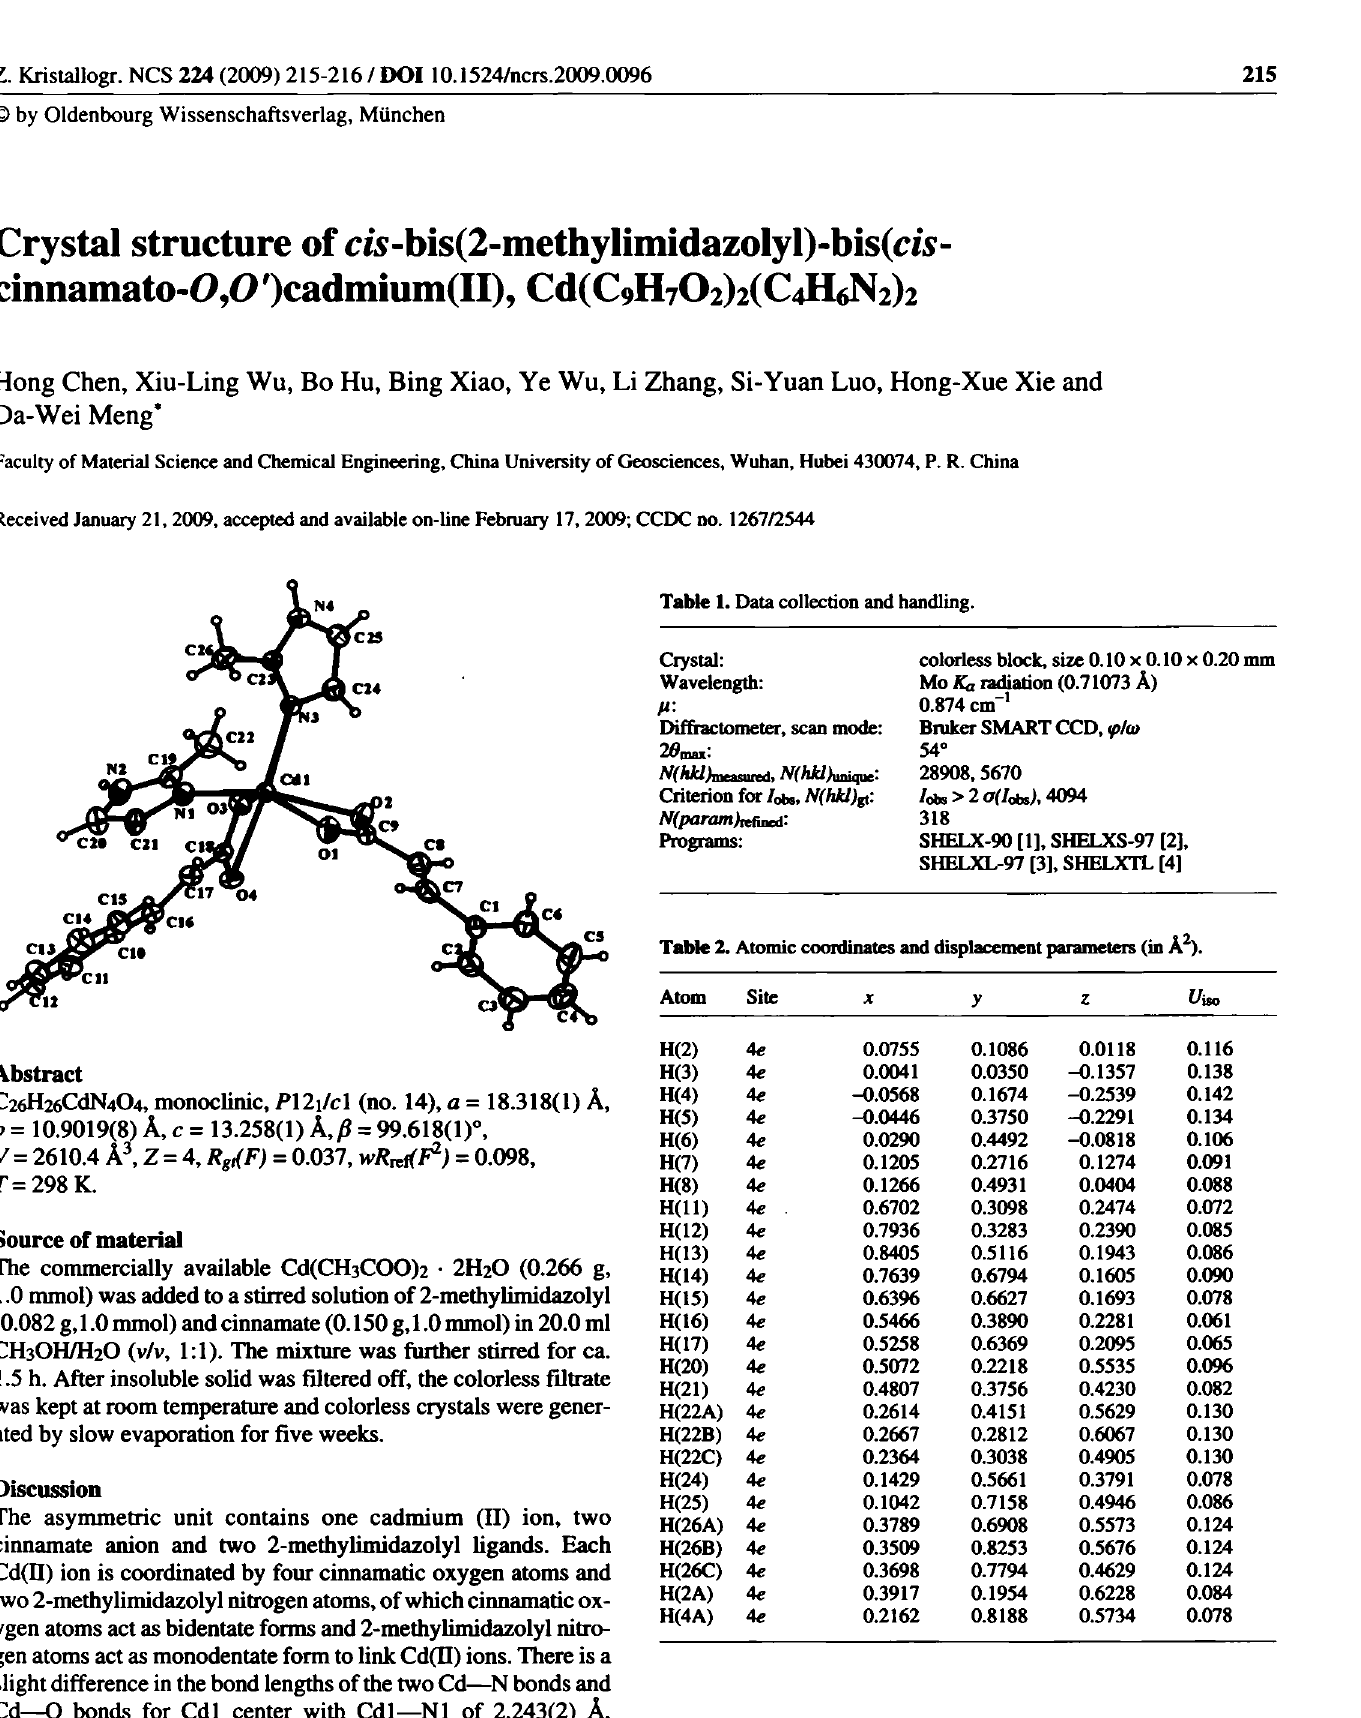
Table 2. Atomic coordinates and displacement parameters (in À 2